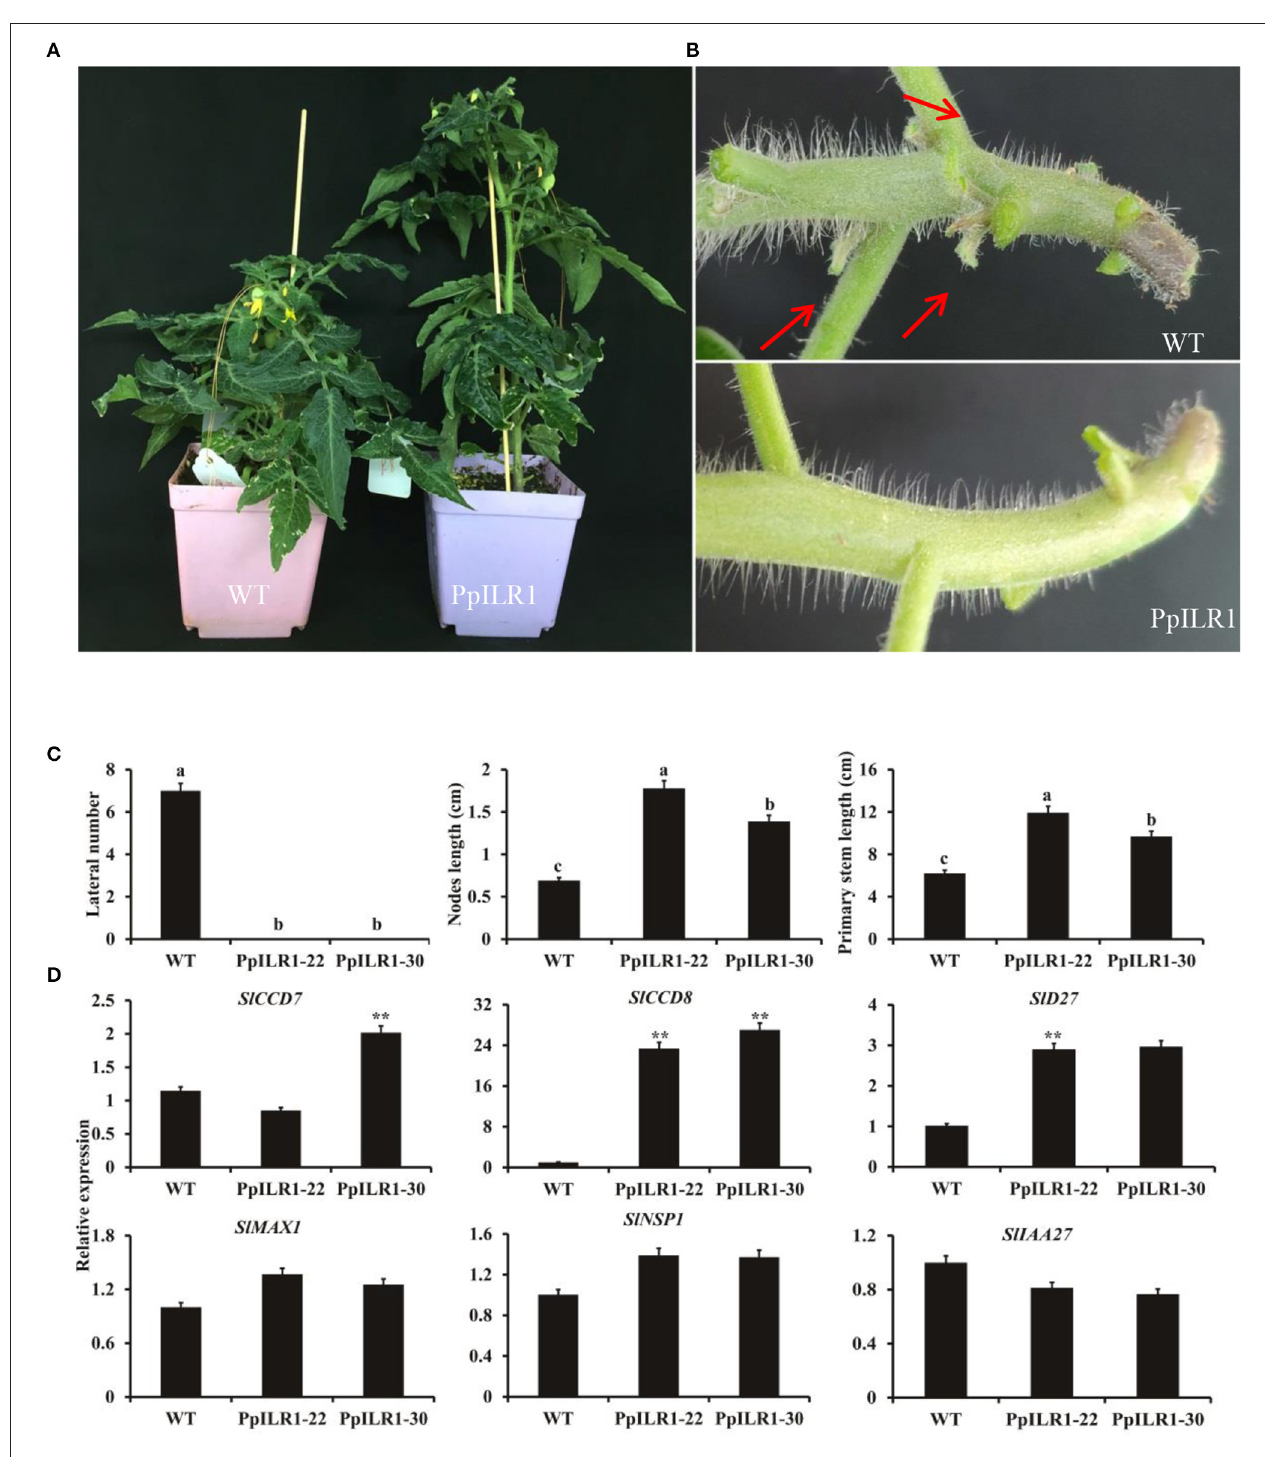
FIGURE 5 | Altered vegetative growth phenotypes of 35S:PpILR1 overexpression tomato lines. (A,B) Photograph (A) and lateral branch number (B) of 7-week-old WT and PpILR1 -overexpressing plants. (C) Close-up of 7-week-old WT and transgenic lines showing the lateral branch number, primary stem length, and internode length. (D) Expression of strigolactone biosynthesis genes in the axillary buds of WT, PpILR1-22, and PpILR1-30 plants. Asterisks indicate significant differences relative to the WT ( P < 0.01; Student’s t -test). Different letters indicate significant differences at P < 0.05.